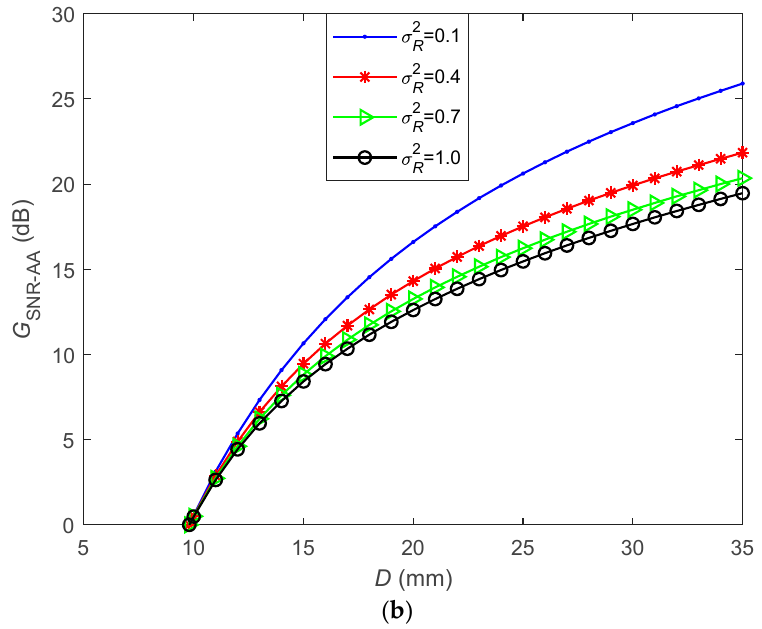
Figure 2. ( a ) Effects of aperture averaging (AA) for a range of D on the signal to noise ratio (SNR) performance as a function of θ 1/2 , and ( b ) the SNR gain as a function of D with AA for a range of σ 2 .